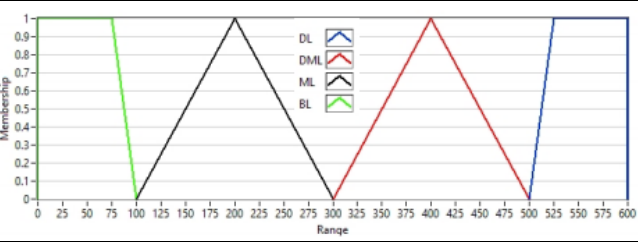
Figure 8: Graph of member functions of Photo l.